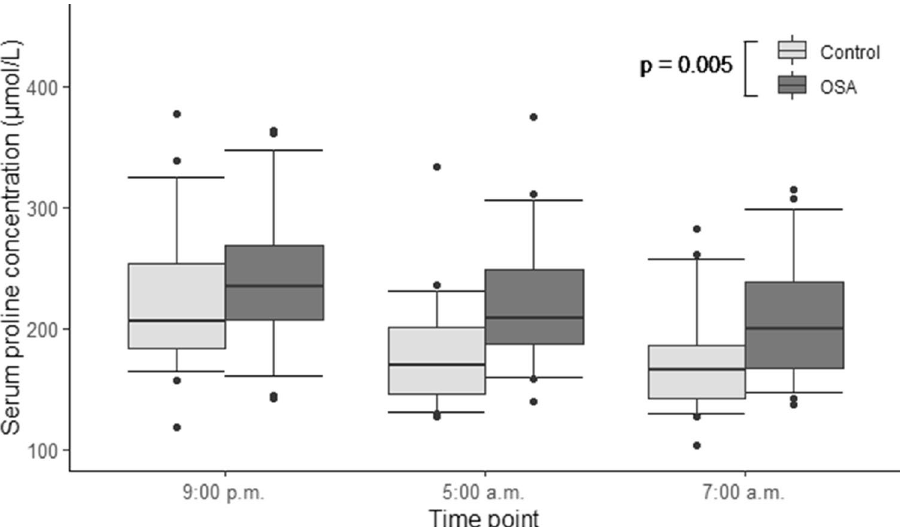
Figure 2. Serum proline concentrations of patients with moderate-to-severe obstructive sleep apnea (OSA) (n = 31) and control individuals (n = 32). General linear model for repeated measures was used on rank transformed data. Proline concentrations were significantly higher in OSA patients, compared to controls ( p =